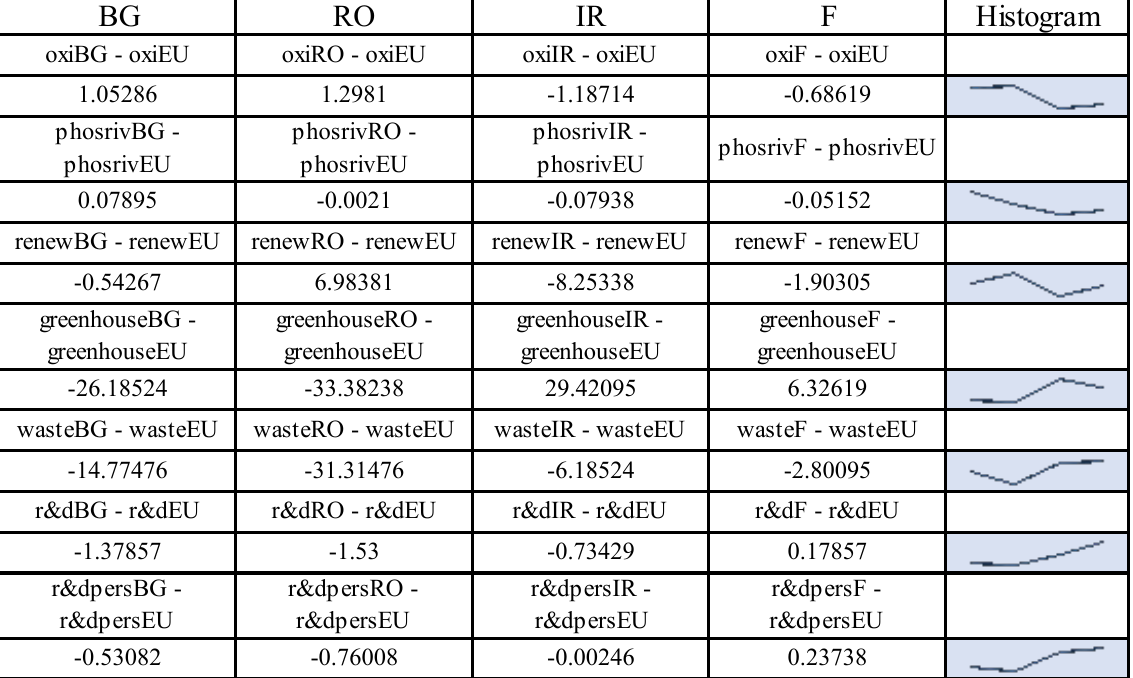
Figure 11. Comparative analysis between the analysed economic entities. Source: Data operated under IBM-SPSS 25 (IBM, Armonk, NY, USA).